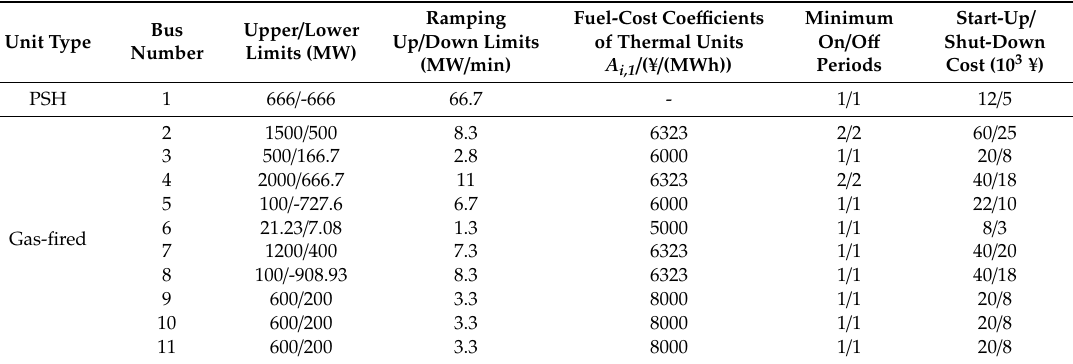
Table 5. Parameters of generator units.